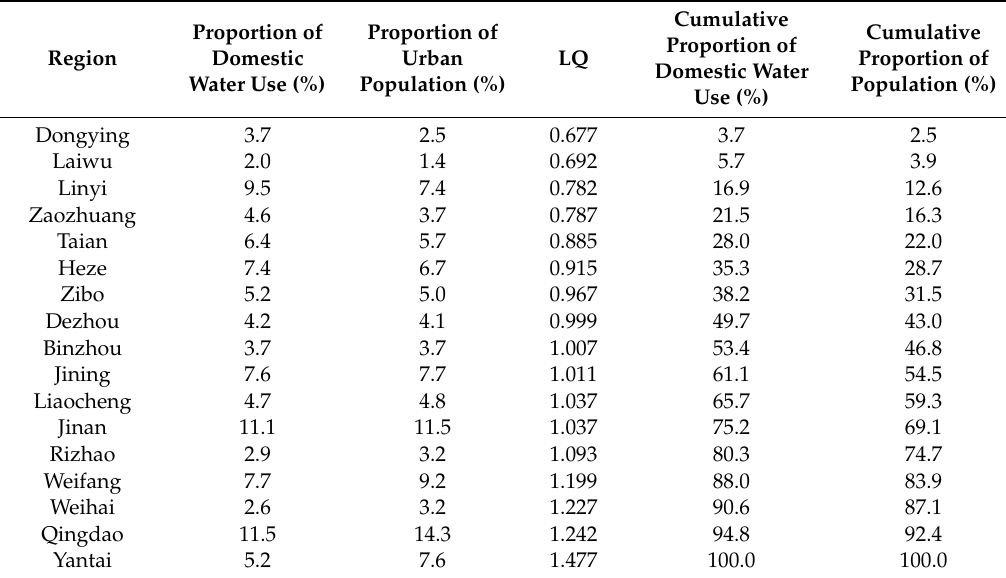
Table 6. Calculation of domestic water use Gini index based urban population of Shandong in 2017. Region